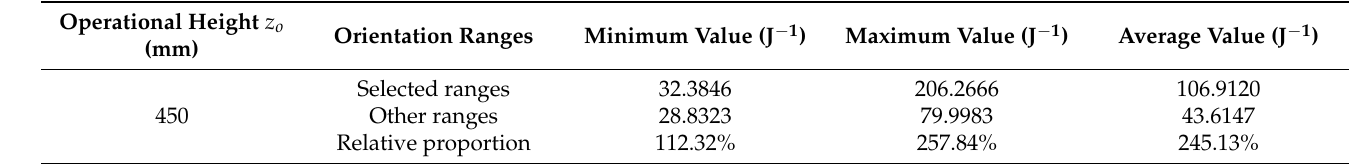
Table 4. Minimum, maximum, and average values of stiffness index in the selected and other orientation ranges with different operational heights.